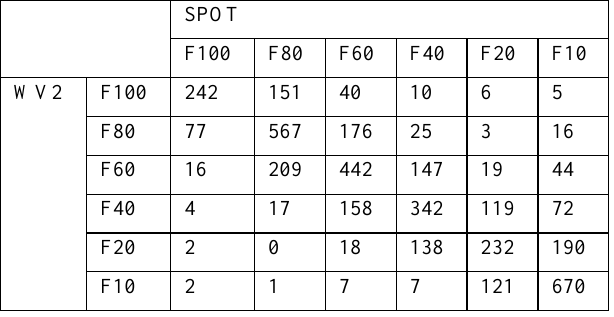
Table 1. Confusion matrix of forest classification with SPOT simulating Sentinel-2 A and B in comparison to Worldview-2.